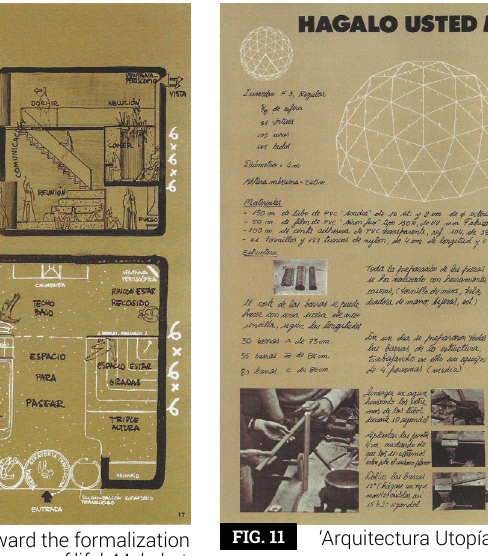
24. These episodes also found empirical application in the many projects for roofs by M. Pedrol’s team, or in the house in La Floresta by J. M. Berenguer.